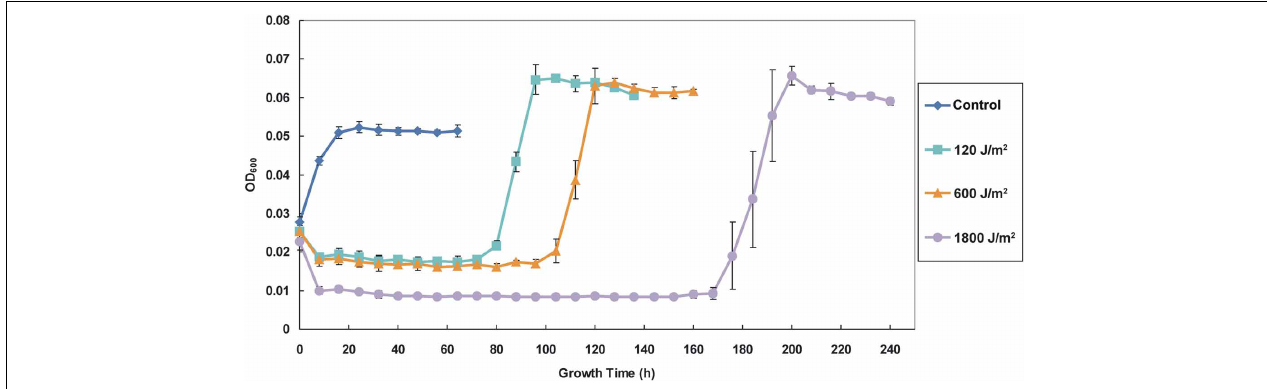
FIGURE 2 | Growth curves of the control (non-irradiated) and the irradiated AMB-1 cells. The diamond, square, triangle and circle shaped lines indicate the growth density (determine as OD 600 ) of the control and irradiated cells after 120, 600, and 1800J/m 2 irradiation.